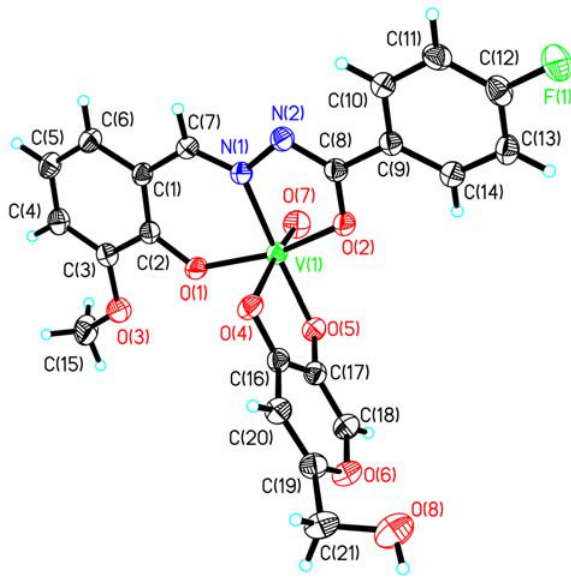
Figure 3. Molecular structure of the complex. Displacement ellip- soids are drawn at the 30% probability level and H atoms are shown as small spheres of arbitrary radii.